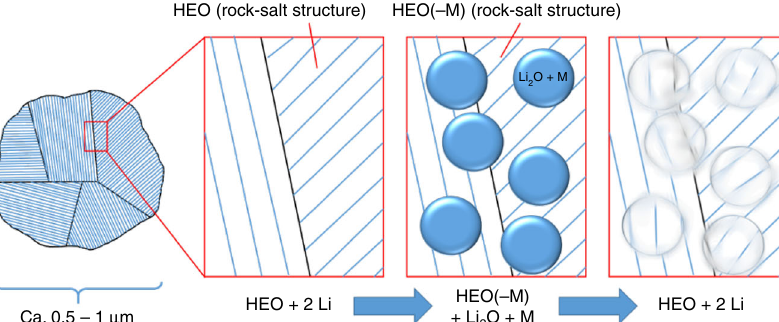
Fig. 6 Schematics of the proposed de-/lithiation mechanism during the conversion reaction of TM-HEO. M in the fi gure stands only for the cations Co, Cu, Zn, and Ni, since Mg is electrochemically inactive in the potential range applied here. The as-prepared TM-HEO is made of poly-/nanocrystallites, exhibiting an ordered structure, as evidenced by SAED, TEM, and XRD. During the lithiation, some of the divalent metals of the TM-HEO react with Li to form nano-Li 2 O and nano-M nuclei via a conversion reaction. The SAED measurements clearly show that the rock-salt structure is preserved in this state. The nanosized nuclei grow inside the rock-salt host structure, causing stresses to build up, thus resulting in the introduction of defects. Consequently, the re fl ections in the XRD pattern disappear — the nuclei “ destroy ” the long-range order; nevertheless, the participating ions remain “ trapped ” inside the host matrix and can easily diffuse back into the crystal structure in the subsequent oxidation process. Hence, the parent HEO structure is restored after